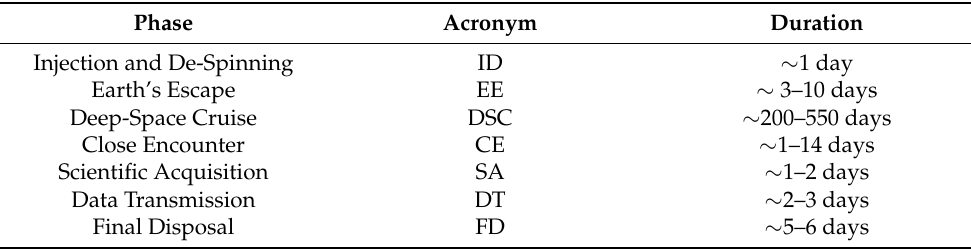
Table 2. Description of the mission